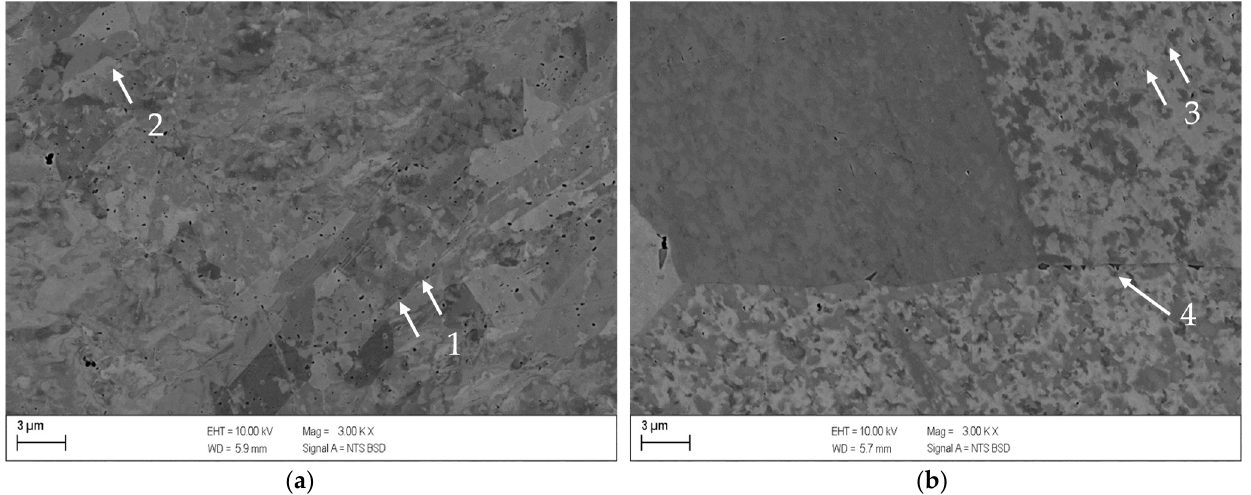
Figure 9. Precipitates of CuSc0.3 in their evolution during DSC measurements: specimen with 75% cross section reduction in cold rolling; ( a ) condition 1; ( b ) condition 2; showing precipitates preferentially at crystallographic defects along slip bands (1), beginning recrystallization in small newly built grains (2), coarsening precipitates at higher temperatures (3), and migration of scandium in intergranular space (4).